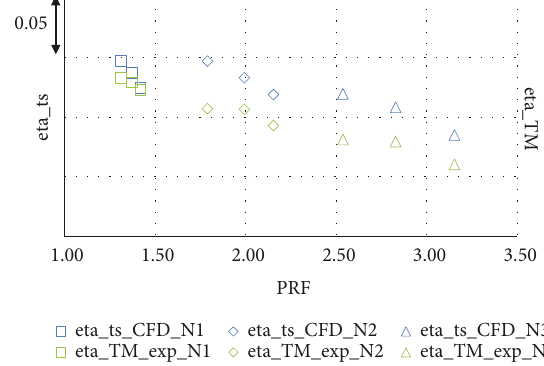
Table 5: Percentage difference for MFP values.